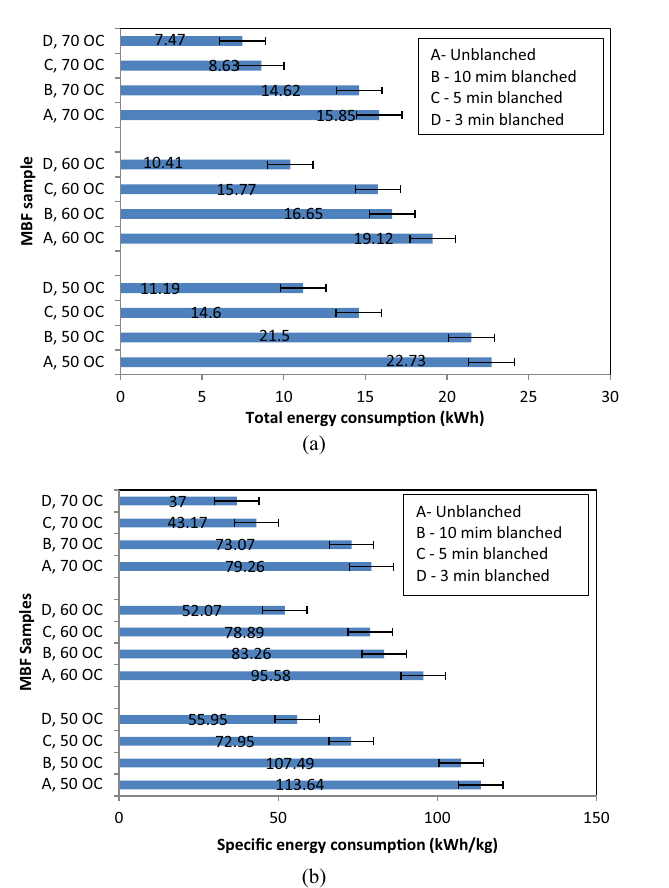
Figure 5. Energy consumption of the drying